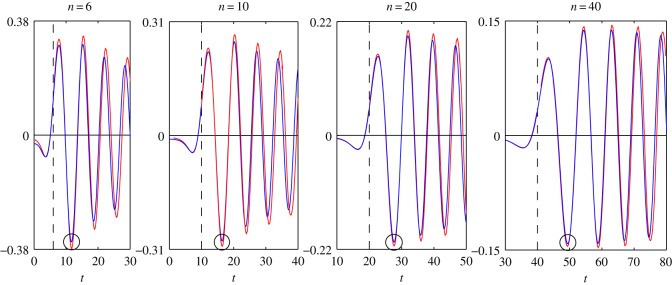
Plots of the functions: s′0,n(t)—blue line; F4(n, t)—red line.